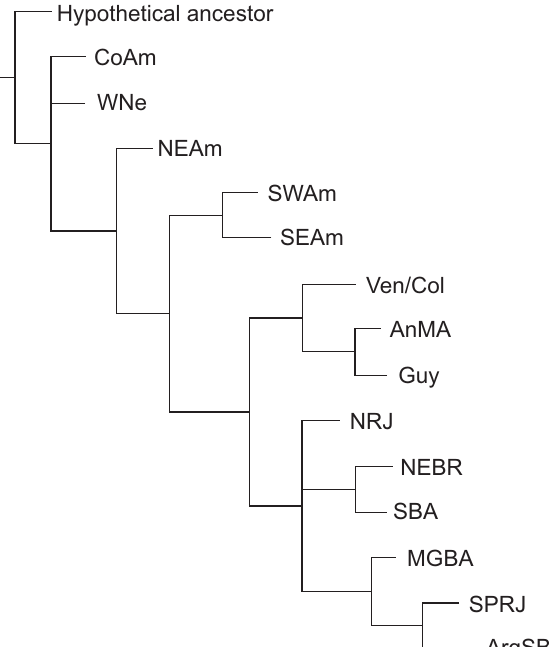
Figure 5. Area cladogram found for the internal sub-components within the Southeast and Northwest components of A MORIM & P IRES ’ (1996) classification, according to Sepedonea distribution. AnMA – Andes and part of Central America; Ven/Col – Venezuela and Colombia; Guy – Guyanas; CoAm – Colombian Amazonia; WNe